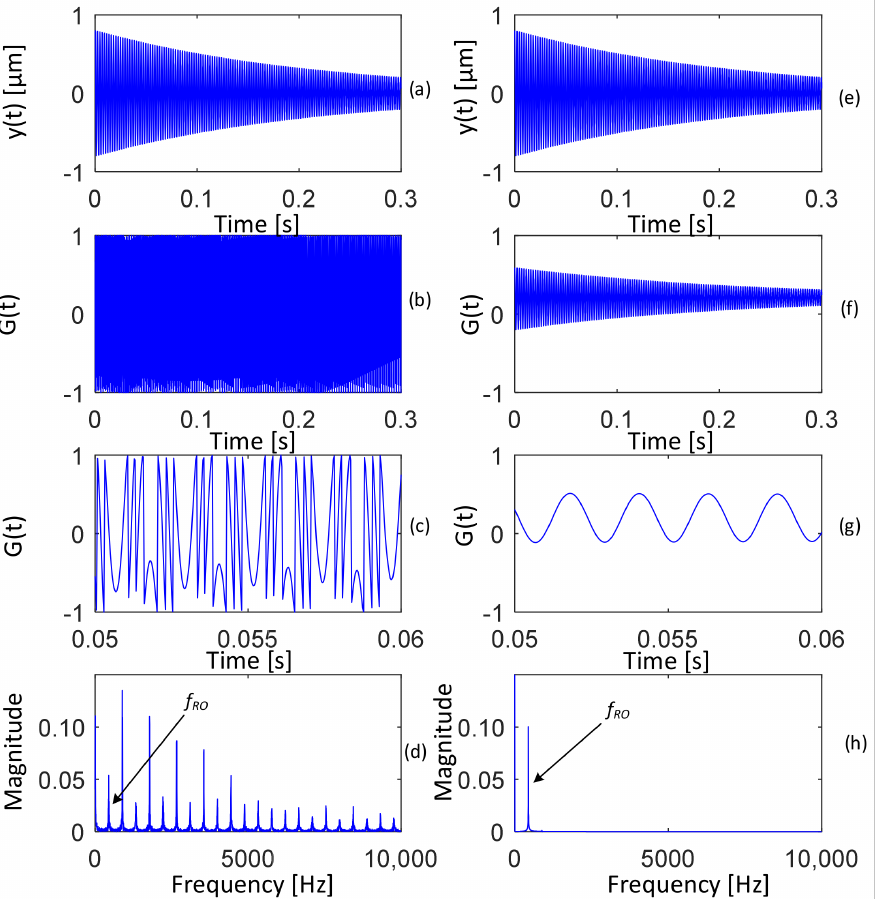
Figure 4. Simulation results, ( a , e ) the vibrations of the specimen; ( b , f ) SMI signals; ( c , g ) the zoomed part from 0.05 s to 0.06 s in ( b , f ), respectively, ( d , h ) the FFT results of ( b , f ),